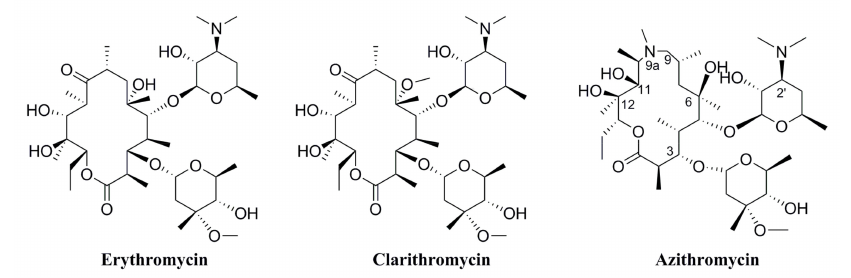
Figure 1. Chemical structure of macrolide antibiotics.